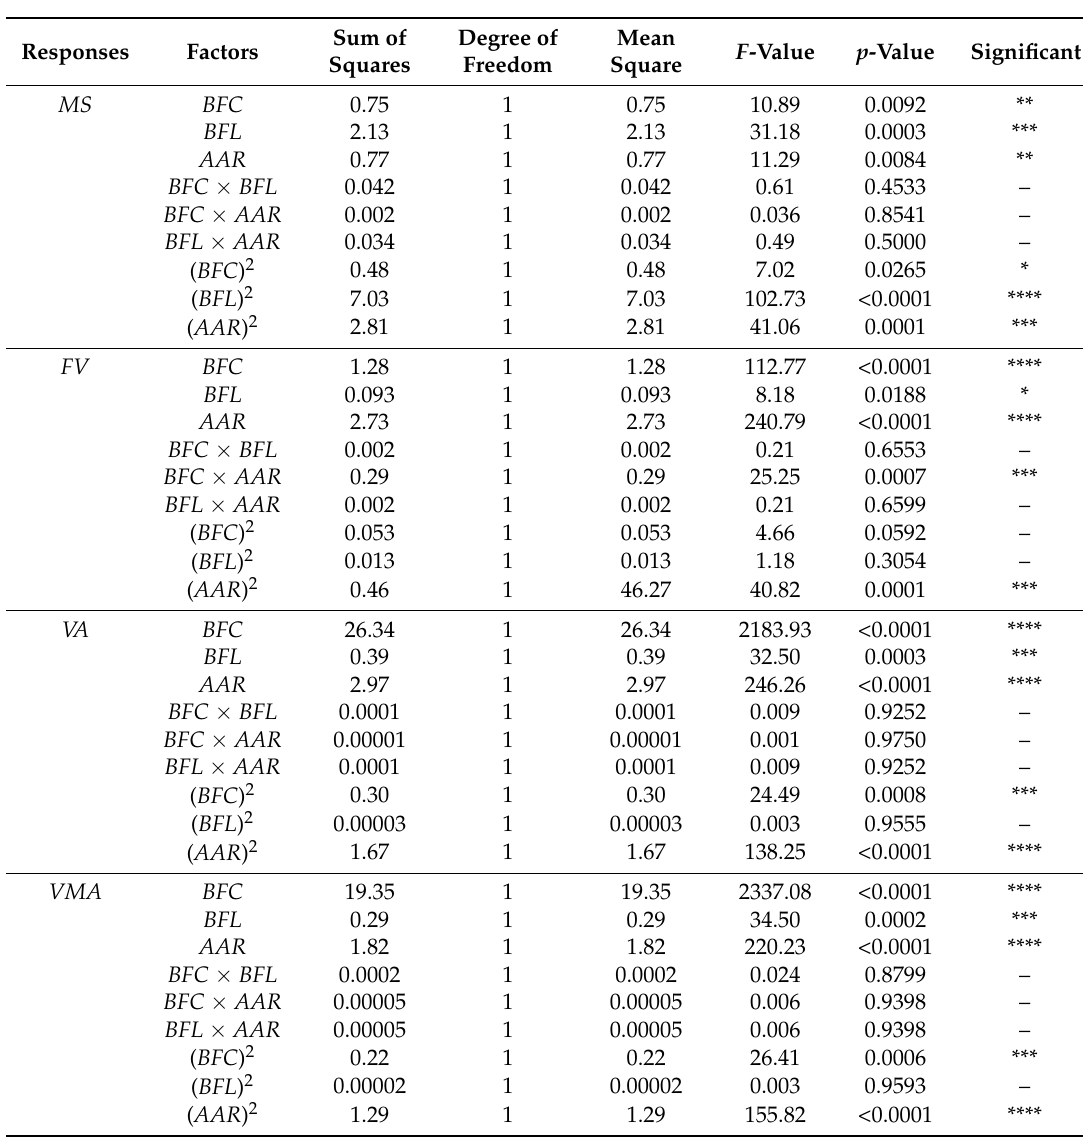
Table 7. ANOVA results for independent